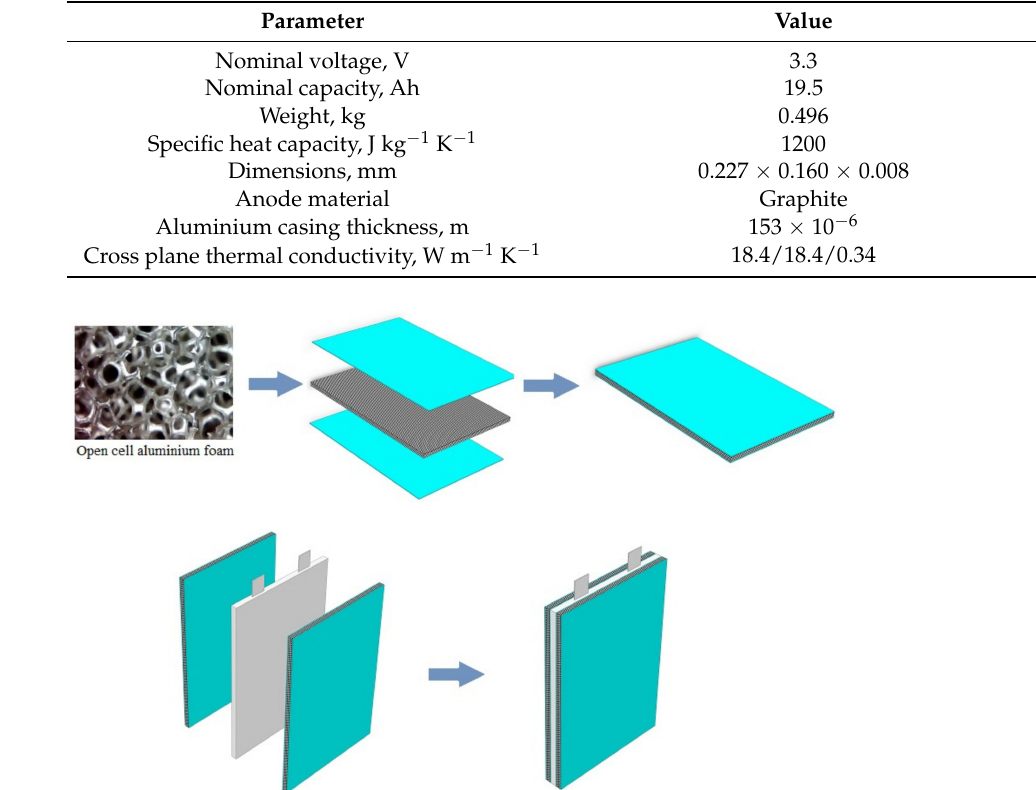
Figure 1. CAD model of battery